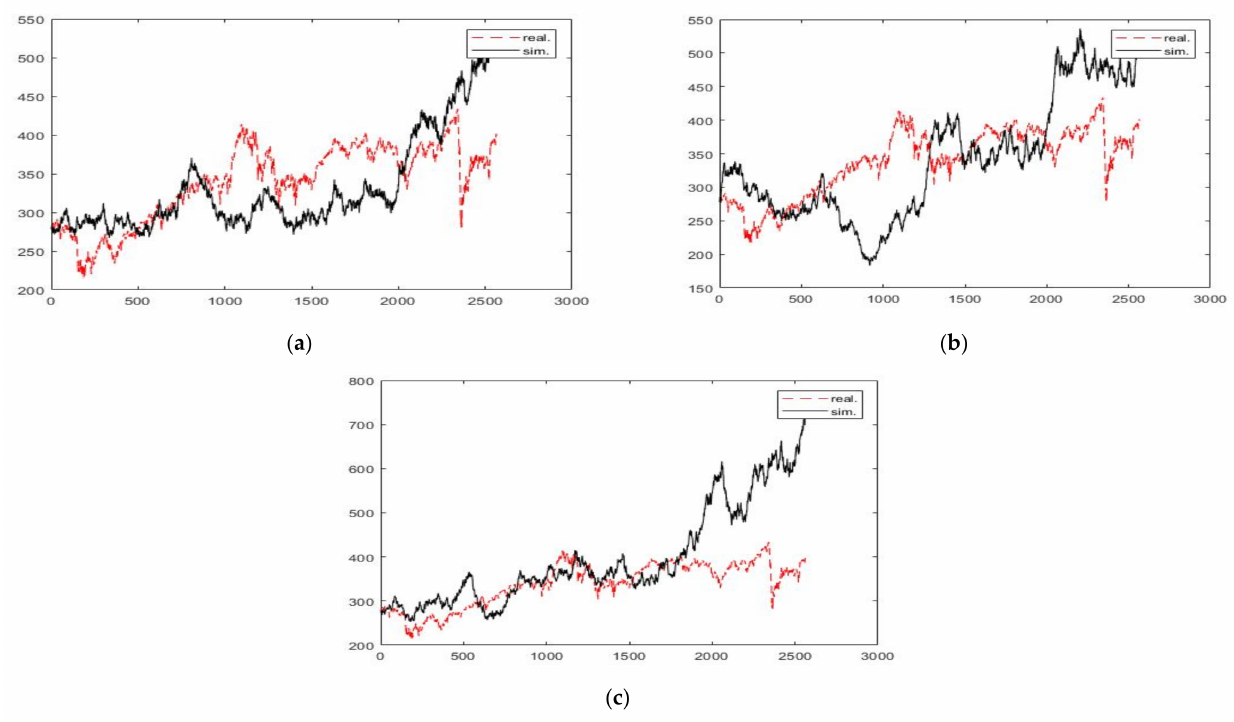
Figure 8. Simulation results using GBM (10-year period): ( a ) Hurst PE, ( b ) Hurst RS, ( c ) Hurst